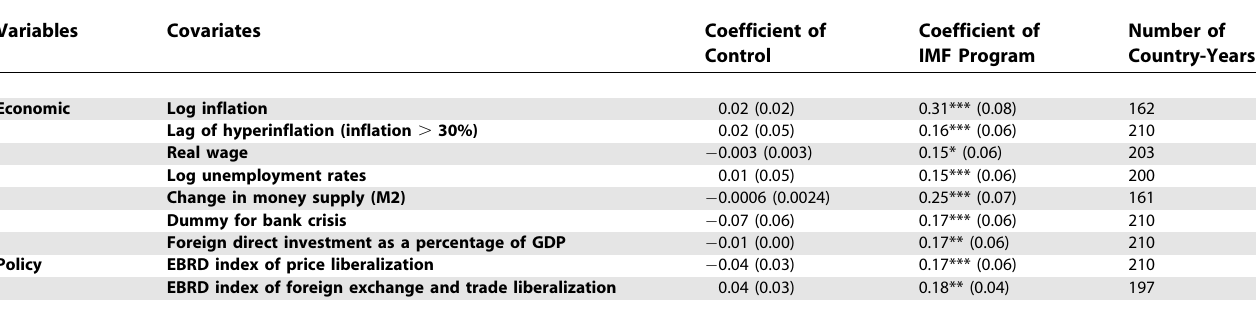
Table 4. Additional Sample and Specification Robustness Checks